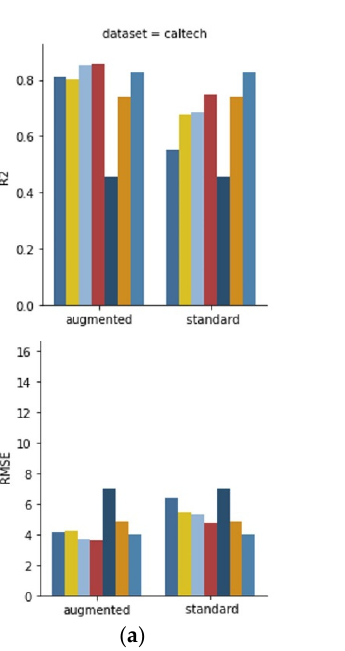
Figure 8. ( a ) R 2 and RMSE for regression models at Caltech for standard and augmented feature set; ( b ) R 2 and RMSE for regression models at JPL for standard and augmented feature set. The left part represents Caltech, and on the right, JPL is displayed. The naïve ap- proach ‘previous day’ performs worst in all cases. Considering Caltech and the standard feature set, only XGBoost has better scores than the naïve approach ‘previous week’, while the approach ‘average’ has the highest R 2 score. The results of the naïve approach ‘aver- age’ are similar to those achieved by RF for JPL and augmented feature set. Over both